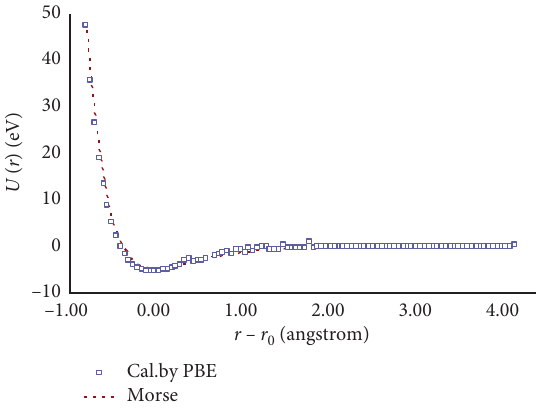
Figure 2: Potential energy vs. diatomic distance for